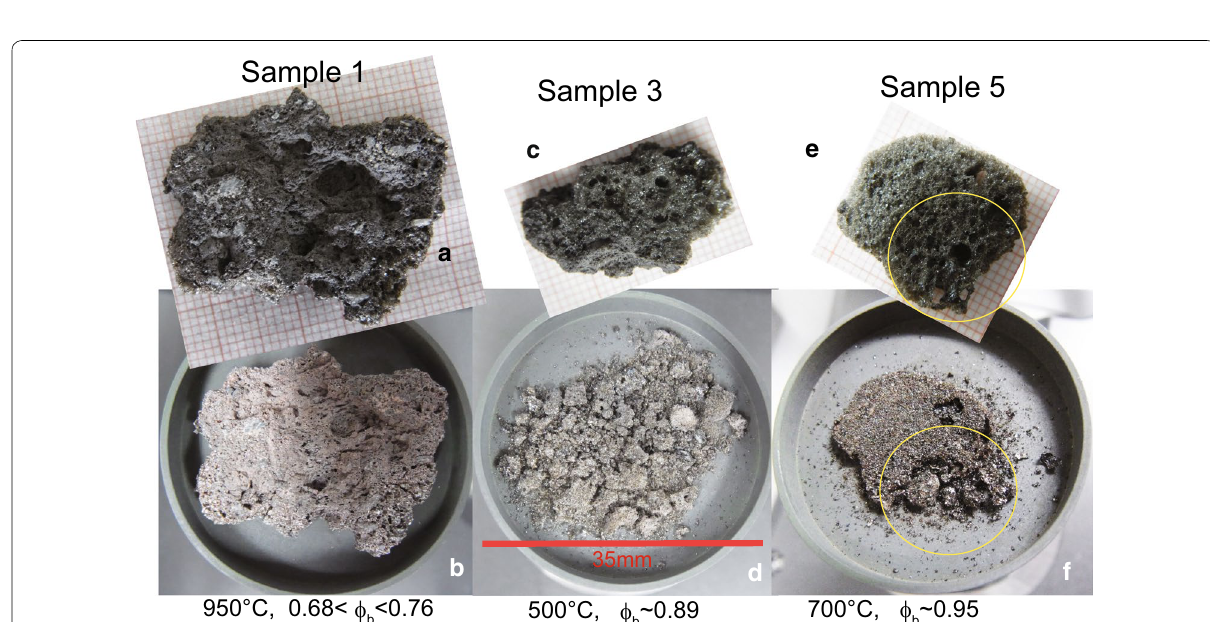
Fig. 6 Pictures of scoriae fractured by shear deformation. Pairs a , b , c , d , and e , f show photographs of Samples 1, 3, and 5 in Table 1 before and after shear deformation, respectively; a shows the scoria before Run 1, and b is after Run 3. b Shows shrinkage. d Shows fracturing into several blocks with various sizes. f Shows partial fracturing. High-porosity parts denoted by the yellow circles fracture and generate small particles, but other parts